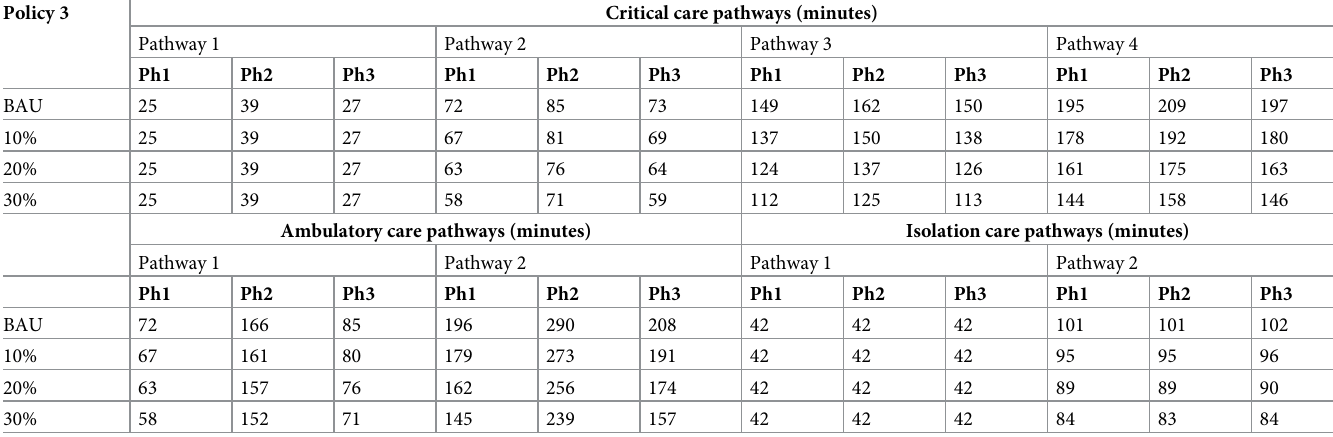
Table 3. ALOS ED patients face depending on care venue, patient pathway, arrival time for observation ward and laboratory policy where waiting times at the observation ward, and laboratory are reduced by 10% -